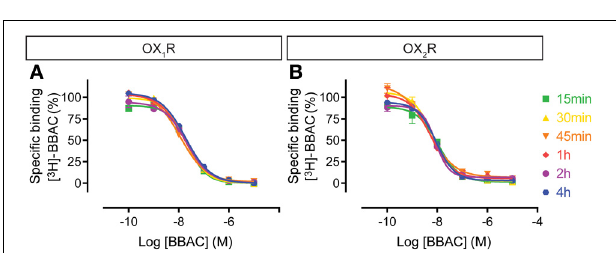
FIGURE 5 | Effect of time on SB-649868 competition for [ 3 H]-BBAC ((S)-N-([1,1 (cid:2) -biphenyl]-2-yl)-1-(2-((1-methyl-1H-benzo[d]imidazol-2- yl)thio)acetyl)pyrrolidine-2-carboxamide) binding to membranes from CHO cells expressing human (A) OX 1 R or (B) OX 2 R. Data is representative of triplicate determinations and error bars indicate